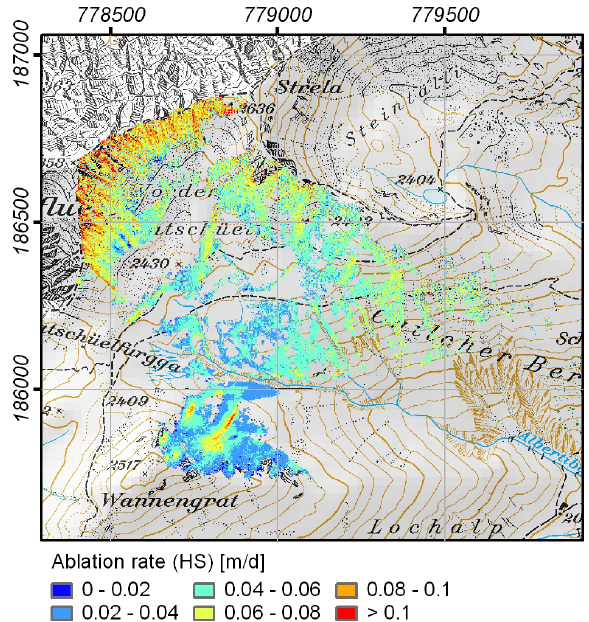
Fig. 8. Daily ablation rate in snow depth ( HS ) averaged for the time periods 26 April–13 May. (base map: Pixelkarte PK25 © 2009 swisstopo (dv033492).